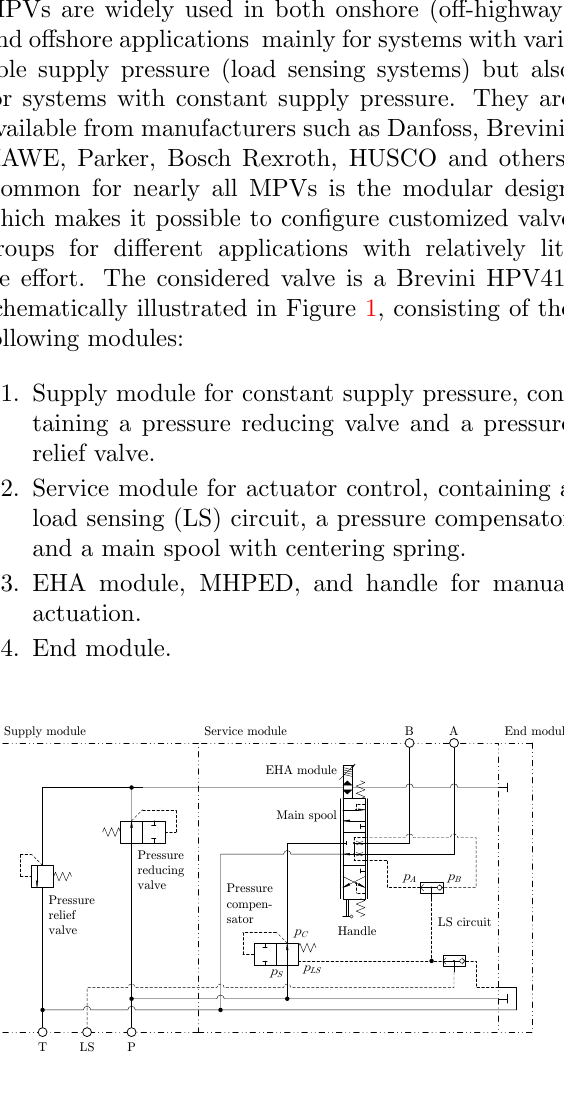
Figure 1: Schematic overview of the considered valve. The pressure reducing valve in the supply module reduces the supply pressure to a level needed for the pilot stage, which is integrated in the EHA module. The pressure relief valve protects the pilot stage from pressure